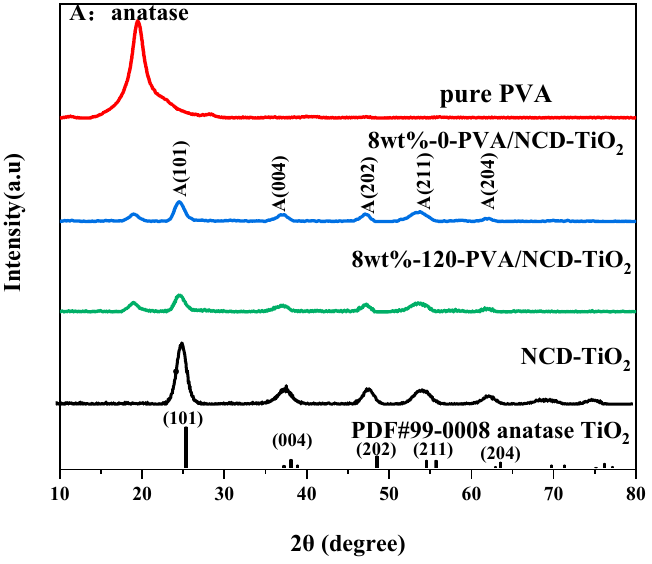
Figure 2. XRD spectra of pure PVA, 8 wt%-0-PVA/NCD-TiO 2 , and 8 wt%-120-PVA/NCD-TiO 2 .